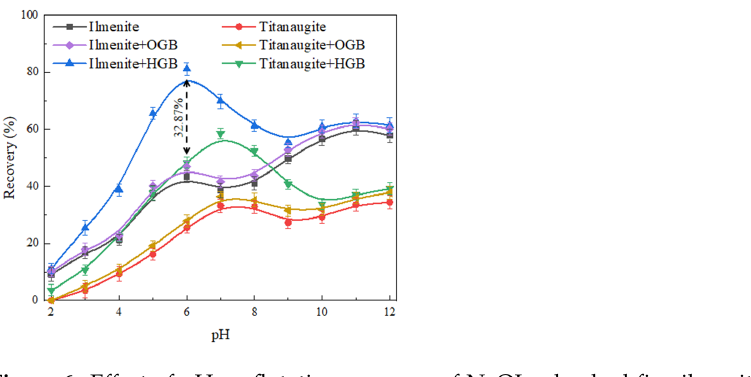
Figure 7. Effect of pH on flotation recovery of fine ilmenite and fine titanaugite mixed with HGB after treated with sodium oleate and sodium silicate (the mineral size distributions of 0–19 µm, 4.0 × 10 −4 mol·L –1 sodium oleate, 10 mg·L –1 sodium silicate, HGB dosage = 0.02 g). 3.2. FTIR Analysis Figure 8 shows the infrared spectra of NaOL, ilmenite, HGB, and both materials treated with NaOL (4.0 × 10 −4 mol·L −1 ) at a pH of 6.0. On the IR spectrum of NaOL, the bands at 2922.80 and 2851.68 cm −1 are previously attributed to the C-H stretching vibra- tions of methyl and methylene –CH, respectively. The bands at 1561.00 and 1449.36 cm −1 belong to the –COO– vibration, the band at 1561.00 cm −1 corresponds to the asymmetric stretching vibration of –COOC–, and the band at 1449.36 cm −1 corresponds to the symmet- ric stretching vibration of –COOC– [34].